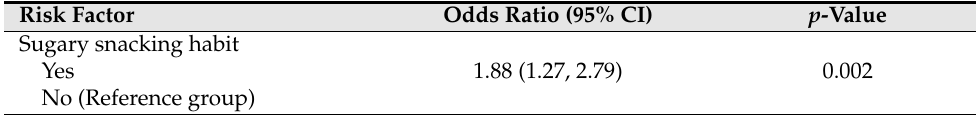
Table 3. Dental caries risk factor for the Hani children (multivariate logistic regression, N = 413). Risk Factor Odds Ratio (95% CI) p -Value Sugary snacking habit